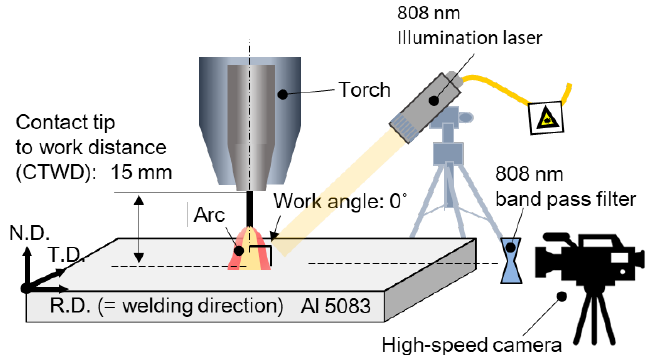
Figure 1. Experimental setup applied in experiment. Table 1. Chemical composition of the substrate and filler wire.